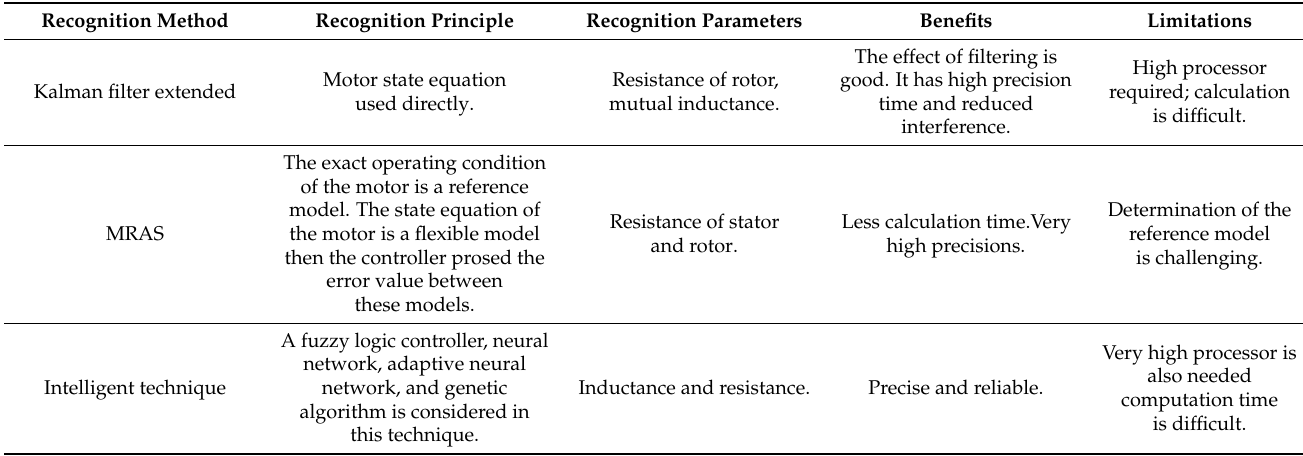
Table 3. Survey for parameter estimation by online identification methods.